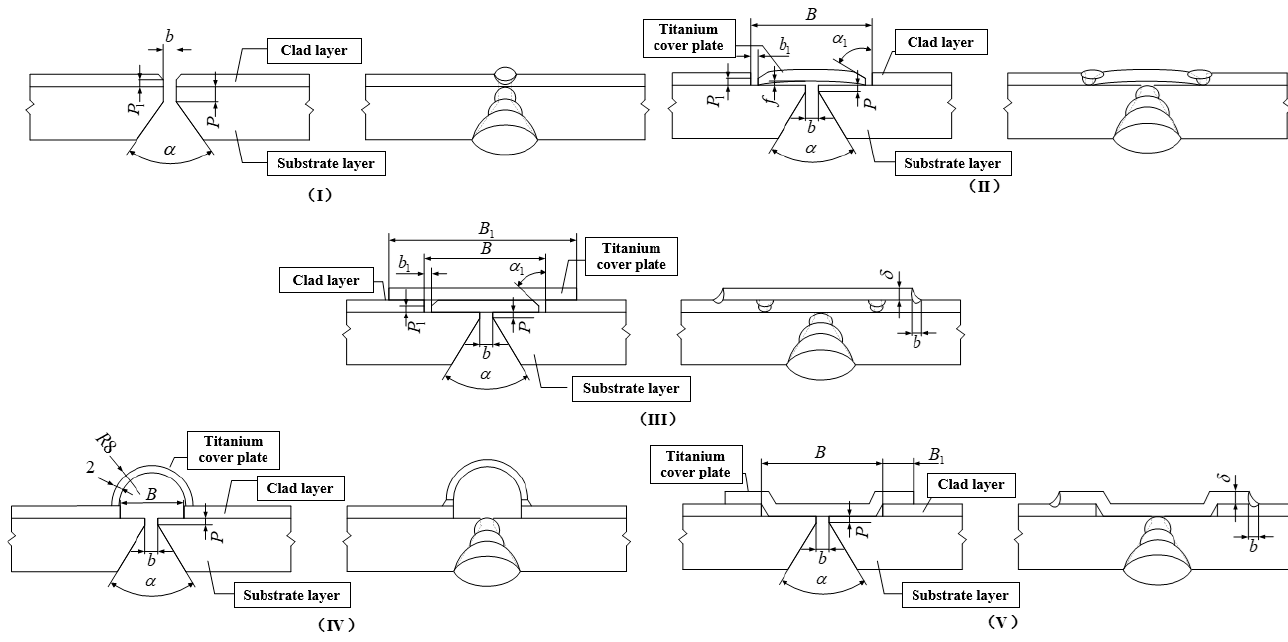
Figure 1. Five types of TC bimetallic steel welded joints provided by GB/T 13149.